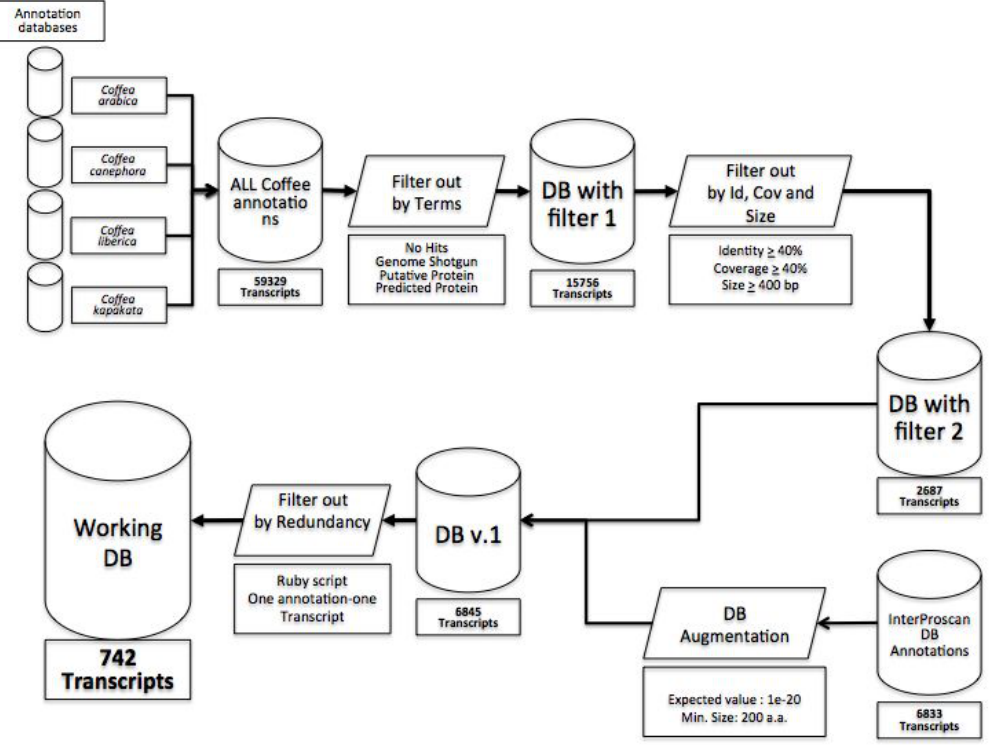
Figure 1: Pipeline for the construction of a biologically significant annotation data set from a collection of Coffea